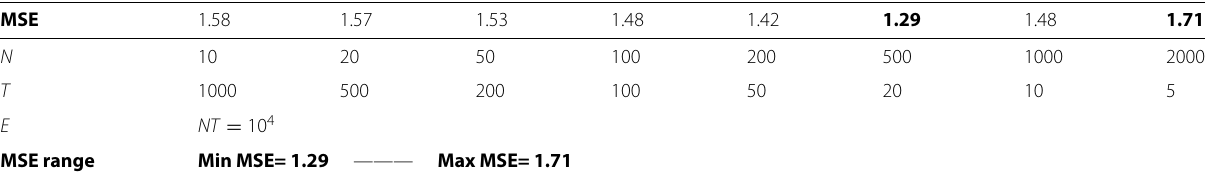
Table 11 Results of the AMIS method for the example in Section 6.4